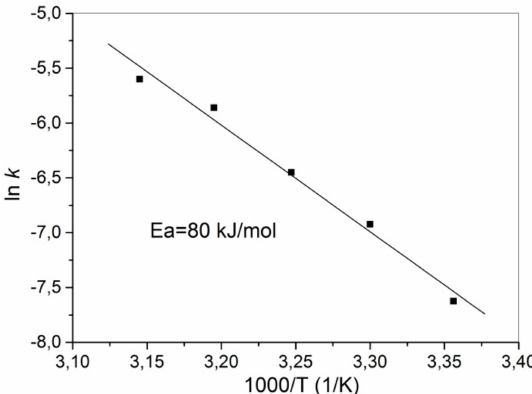
Figure 11. Arrhenius plot of the chalcopyrite oxidation in the H 2 SO 4 -H 2 O 2 -H 2 O